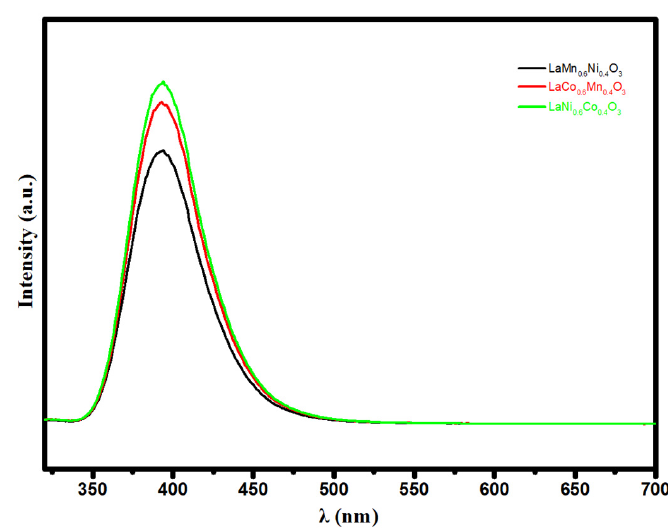
Figure 8. Photoluminescence spectra of LaMn 0.6 Ni 0.4 O 3 , LaCo 0.6 Mn 0.4 O 3 and LaNi 0.6 Co 0.4 O 3.